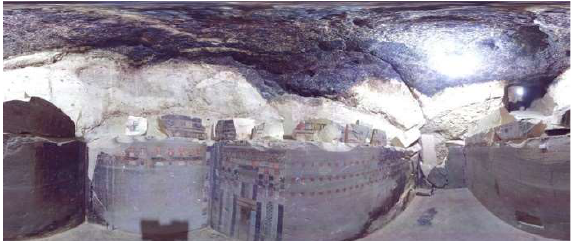
Figure 10. 360º view with scanner 3D. Sarcophagus chamber in Ipi’s tomb.